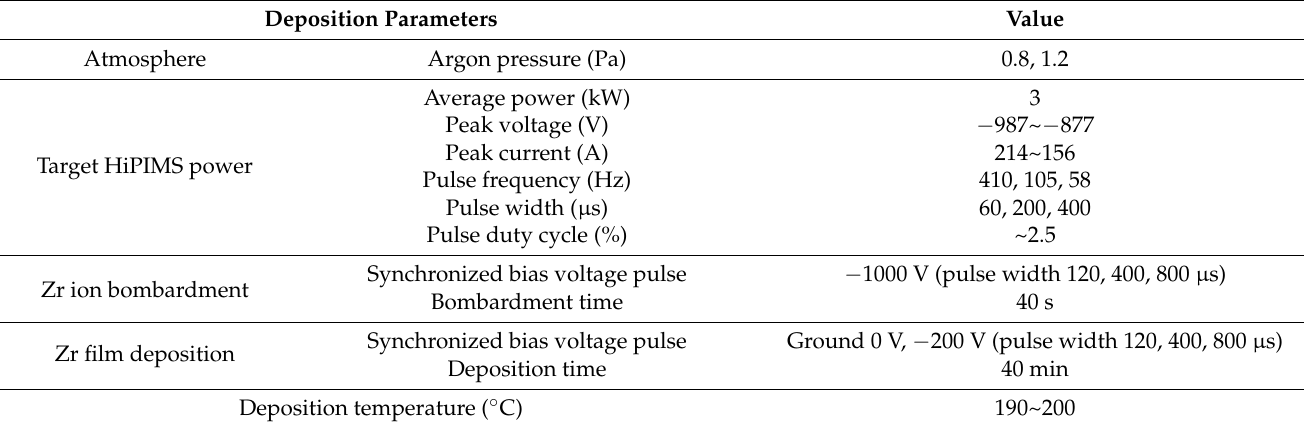
Table 1. Parameters for the deposition of zirconium